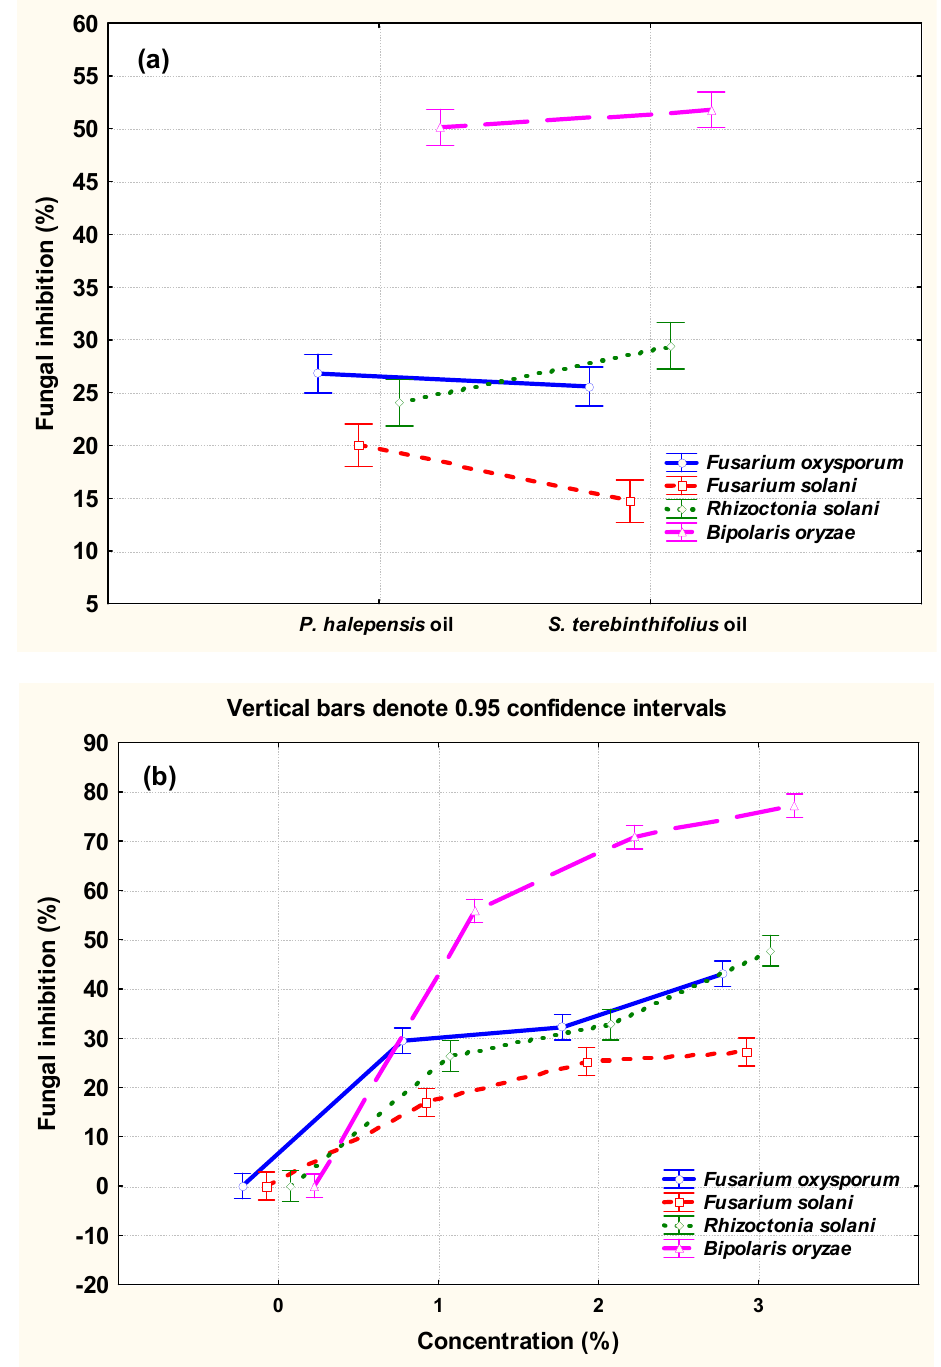
Figure 5. Overall bioactivity of wood treated with P. halepensis OLE and S. terebinthifolius EO; ( a ) EO and OLE source and ( b ) EO and OLE concentration against the fungal linear growth of B. oryzae , F. oxysporum , F. solani, and R. solani .